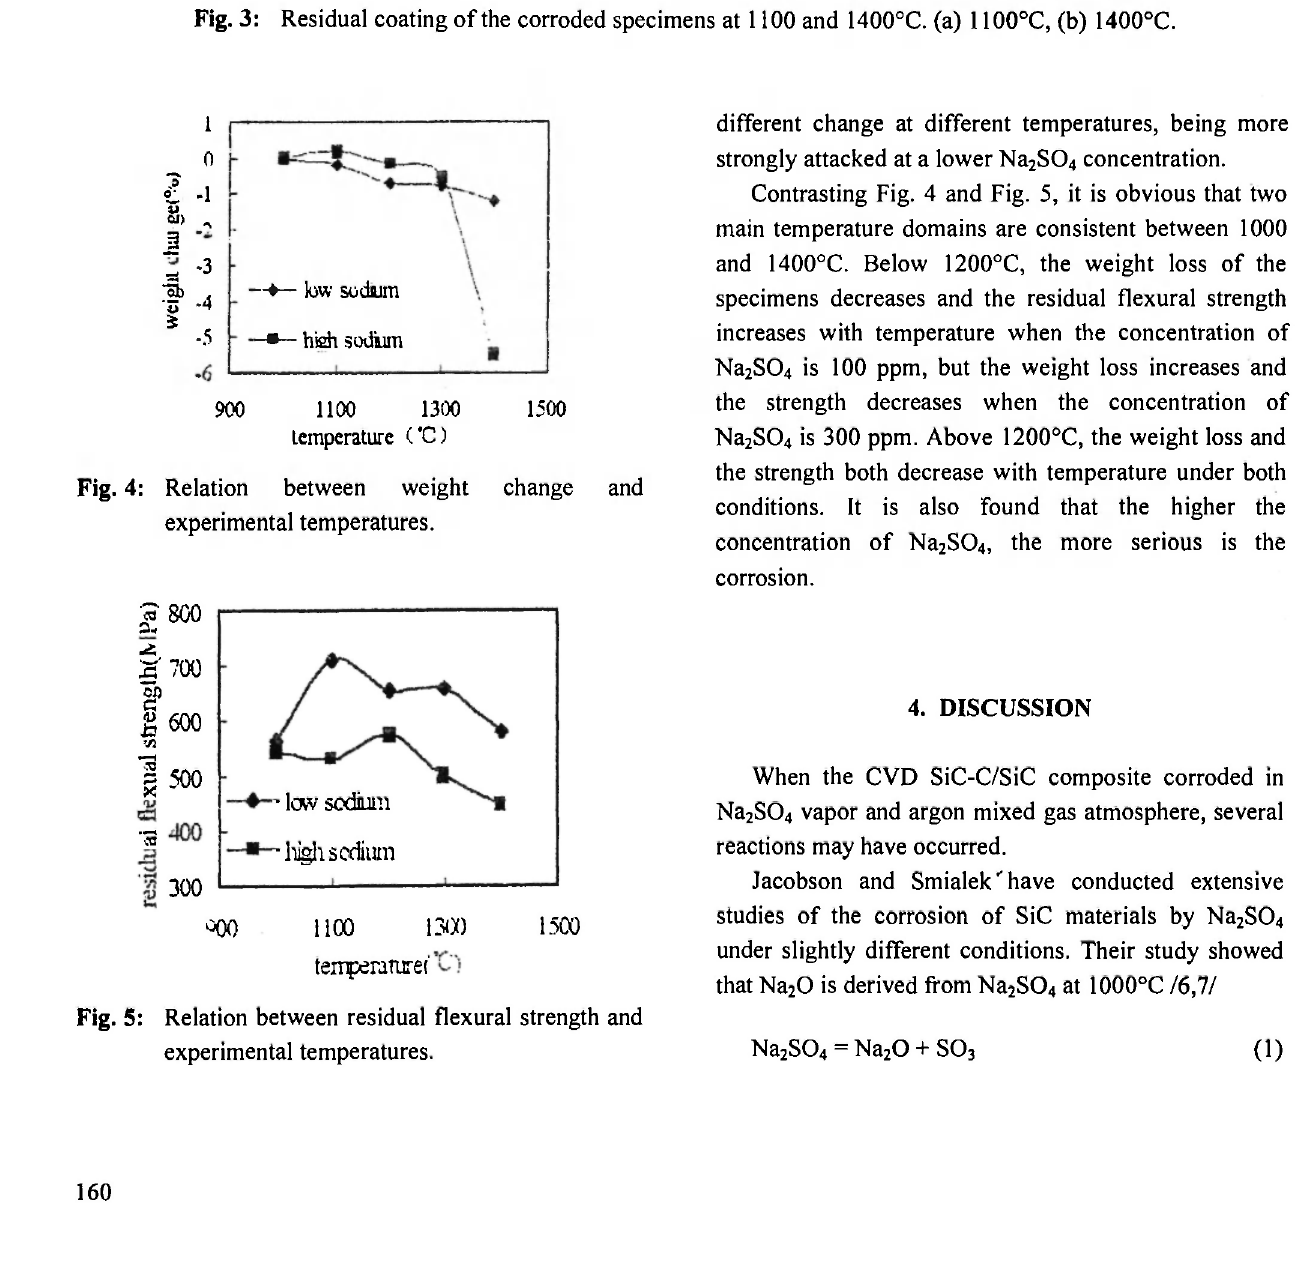
Fig. 3: Residual coating of the corroded specimens at 1 100 and 1400°C. (a) 1100 °C, (b) 1400 °C.